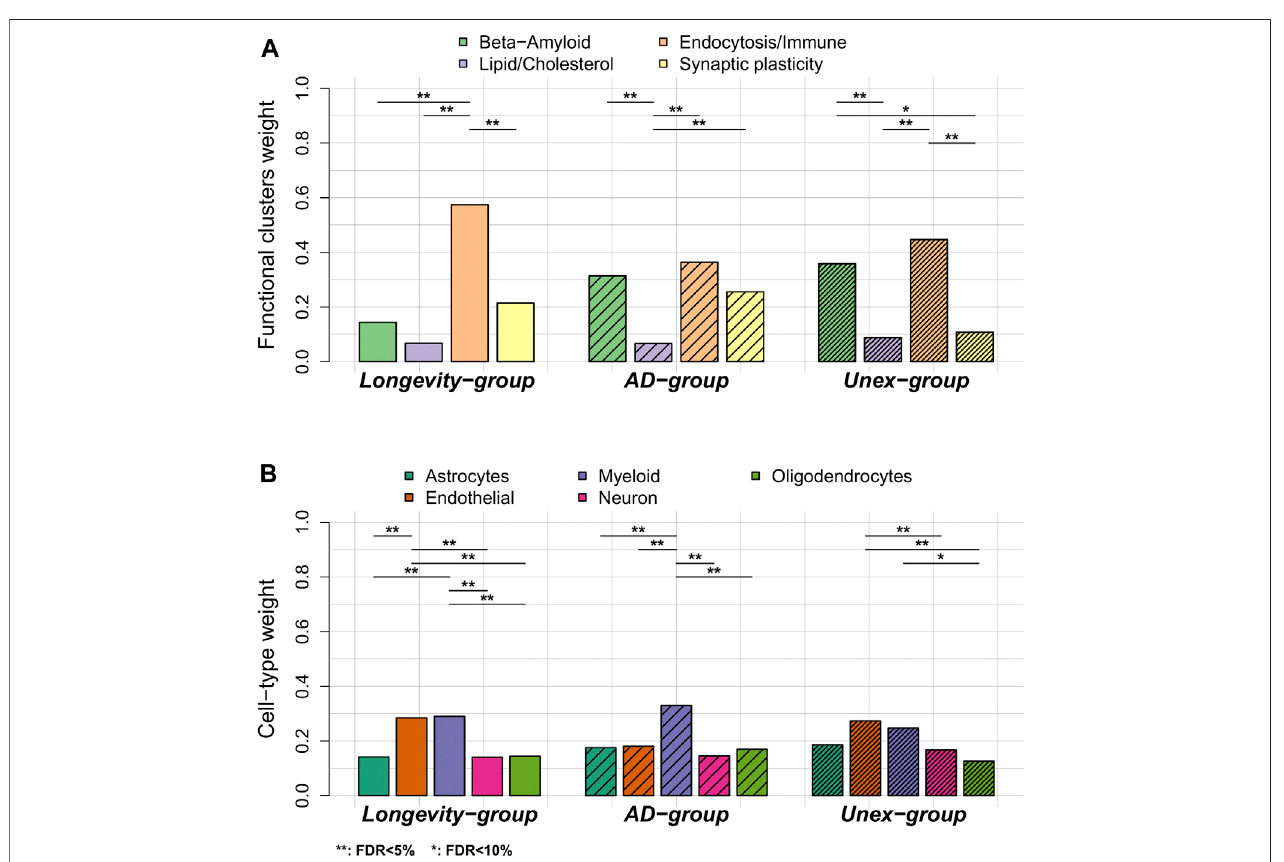
FIGURE3| Comparison offunctional annotationand cell-type annotationwithin the Longevity-, AD- and Unex-groups . (A) Theweightsofthe4 functional clusters within the Longevity-, AD- and Unex-groups . (B) The weights of the different cell-types in the brain, per group. Differences in functional weights and cell-type weights within each group were calculated using Wilcoxon sum rank tests. The resulting p -values were